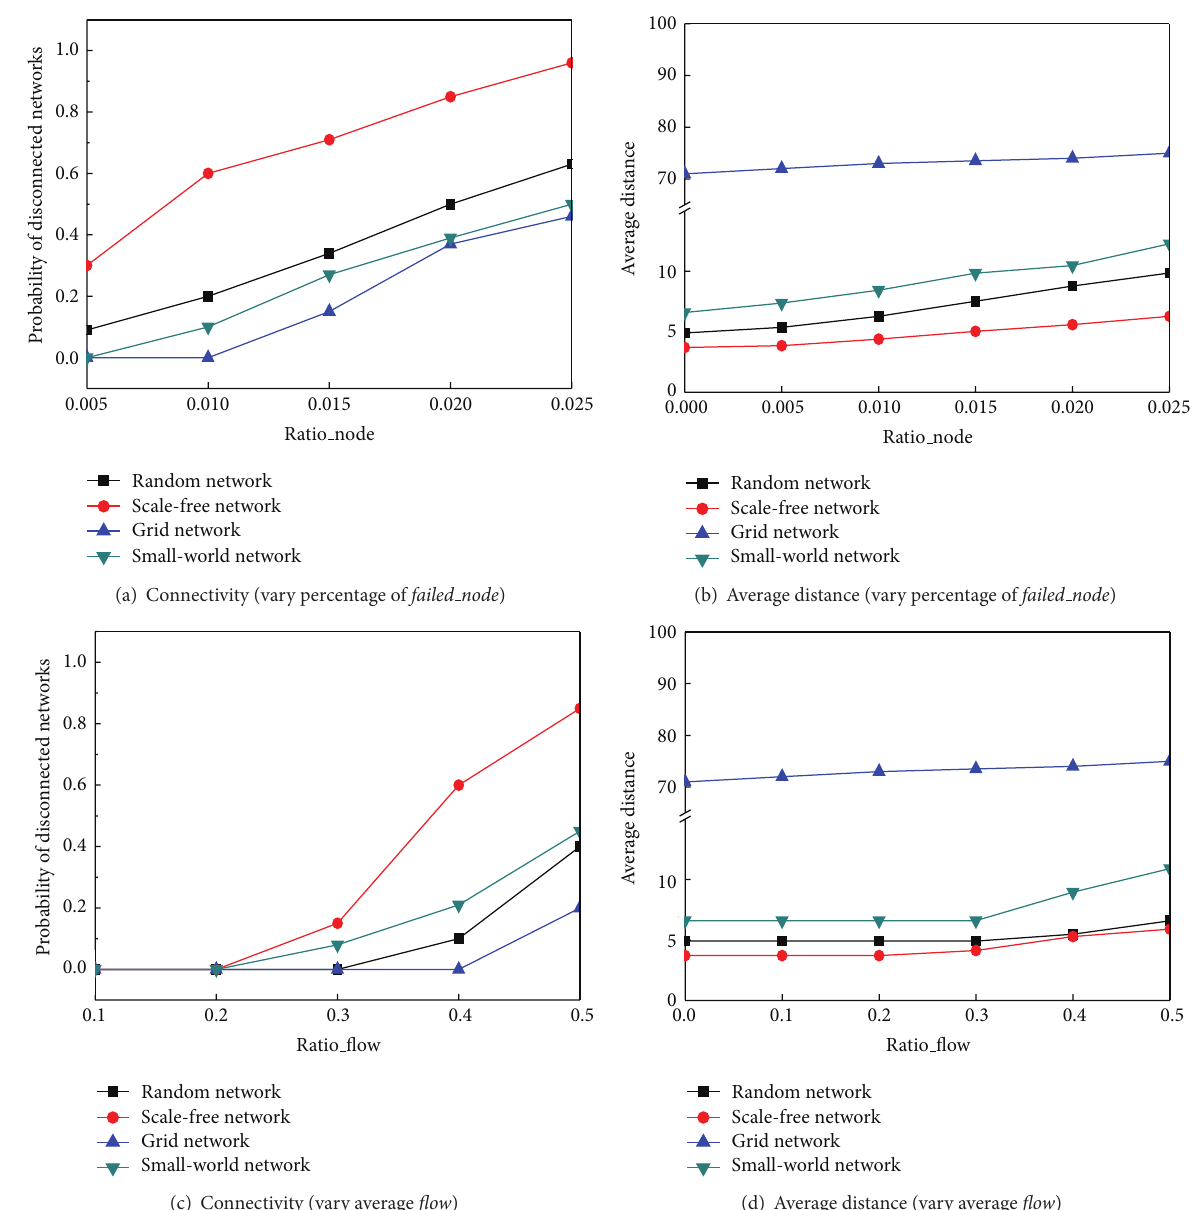
Figure 5: Connectivity and average distance by varying Ratio node and Ratio flow